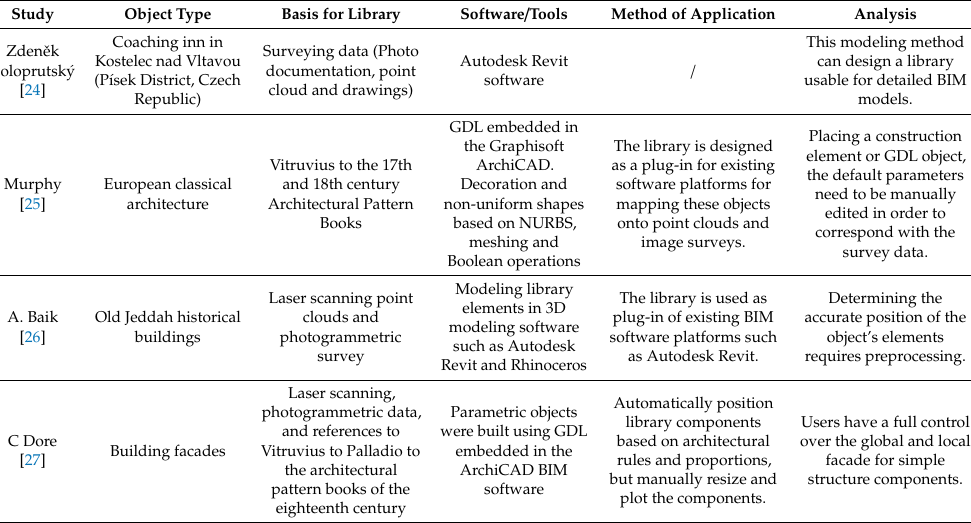
Table 1. A comparison of existing template library used in 3D